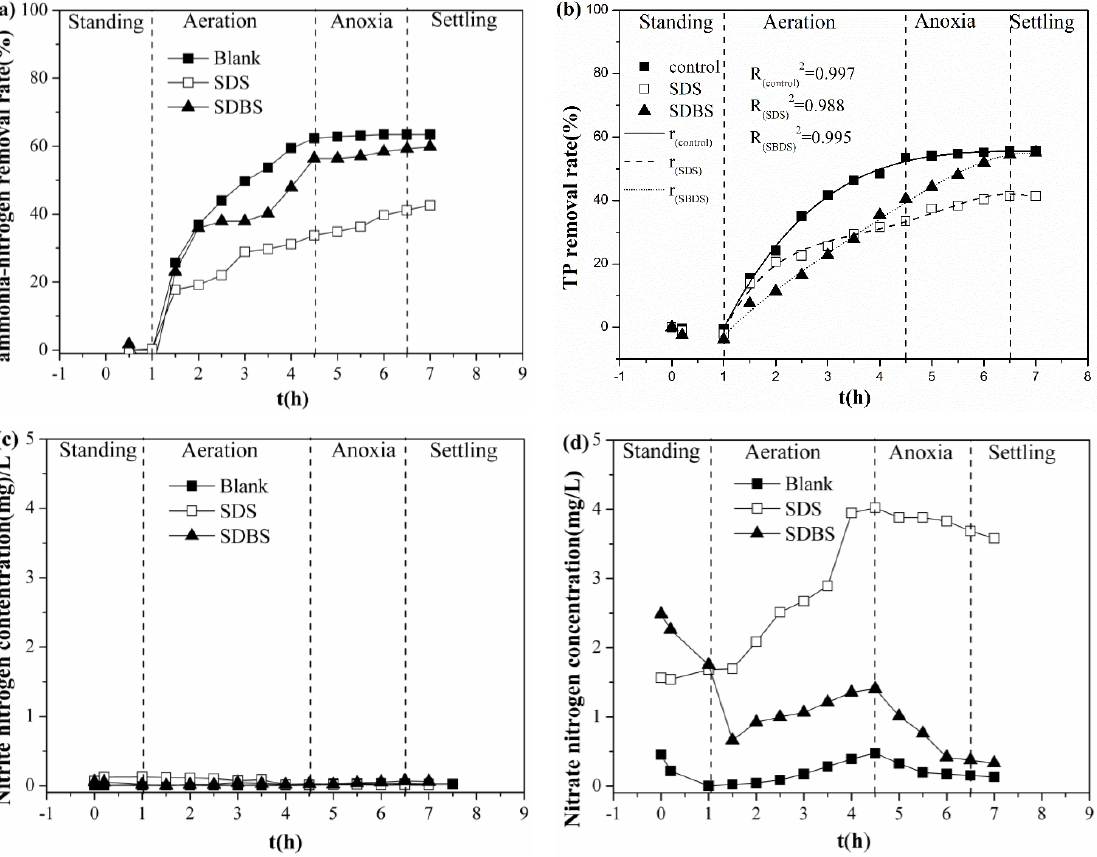
Figure 1. Removal rates of pollutants during an operational cycle: ( a ) NH 4 + -N; ( b ) TP; ( c ) NO 2- -N; and ( d ) NO 3- -N.